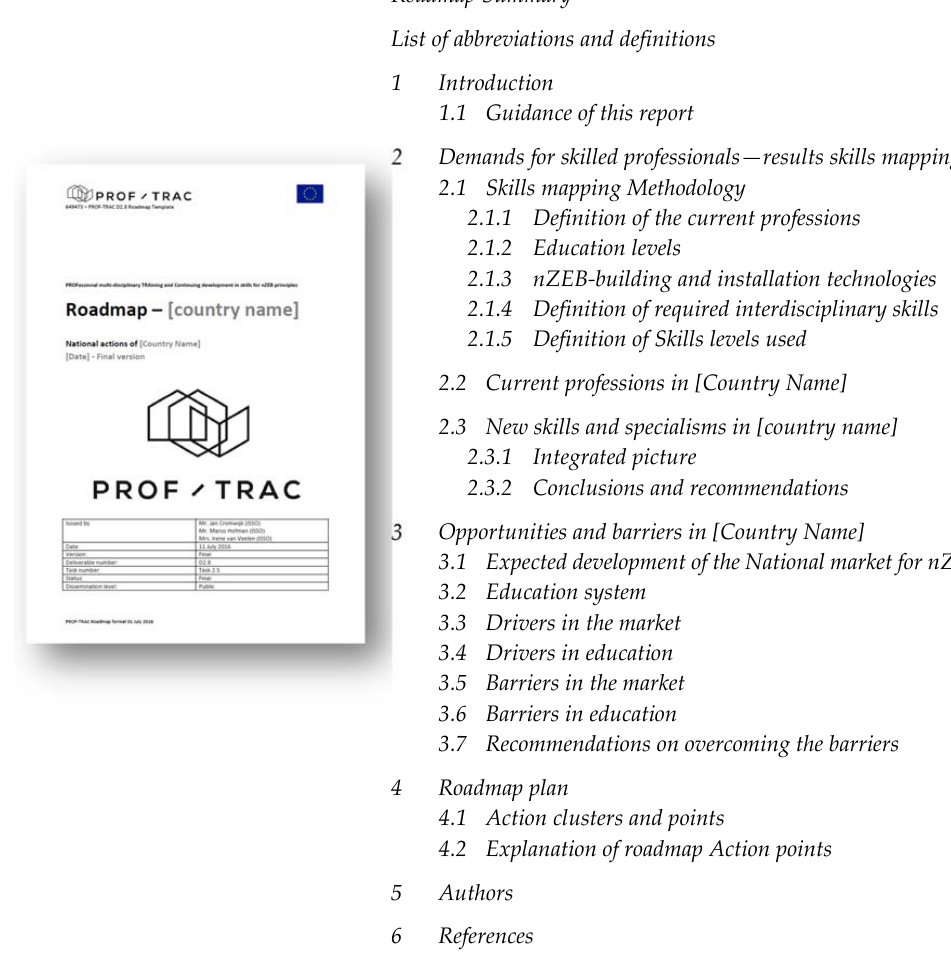
Figure 2. Roadmap template and table of content developed in PROF/TRAC.